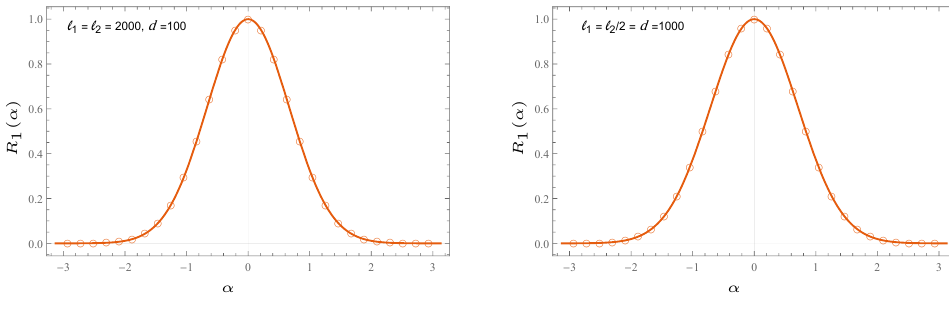
Figure 4 . Plots for charged moments R 1 ( α ) . The continuous lines are plots of R 1 ( α ) (given by using n = 1 in eq. (4.37)) for K = 1 as a function of α . The discrete points are the plots of numerically evaluated charged moments for the tight-binding model given by using β = α in eq. (C.5).